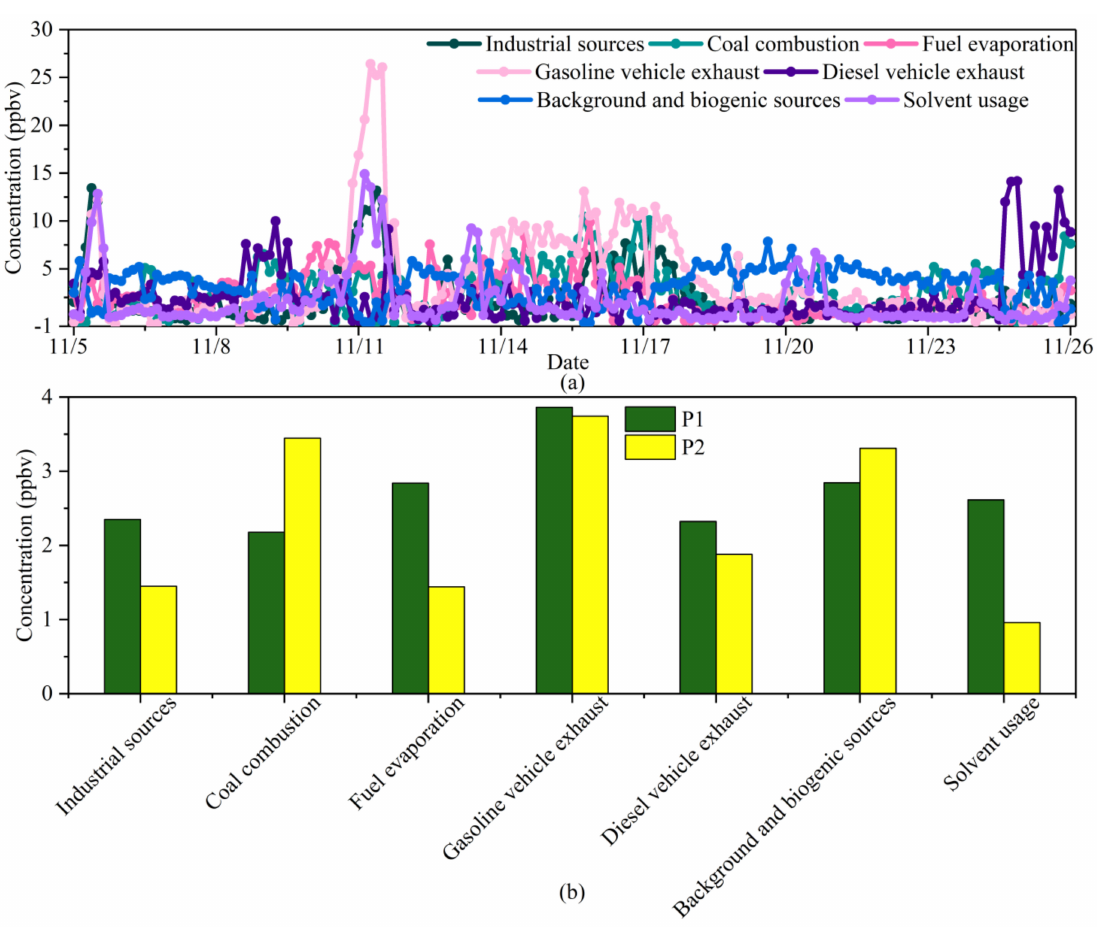
Figure 5. ( a ) Concentration time series and ( b ) average concentration of the PMF-resolved sources of VOCs during P1 and